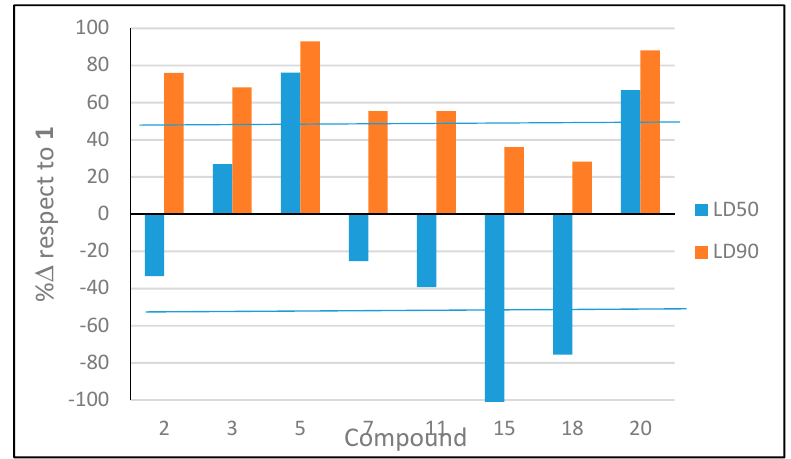
Figure 7. Increment (% Δ ) in ixodicidal activity (LD 50 and LD 90 values) of derivatives 2 , 3 , 5 , 7 , 11 , 15 , 18 , and 20 respect to 1 .